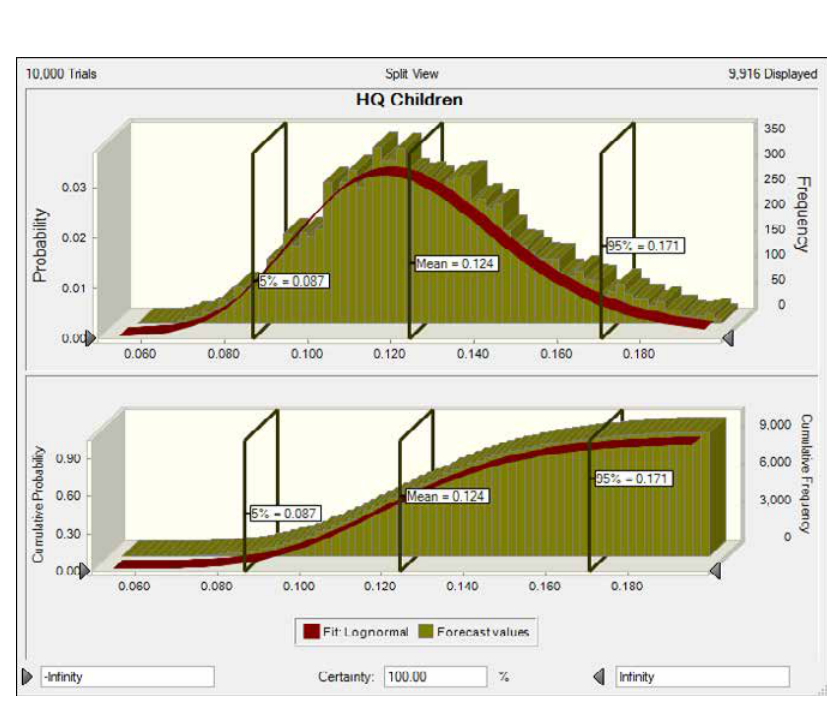
Fig. 4: The HQ of adult (a) and children (b) from PM 2.5 exposure